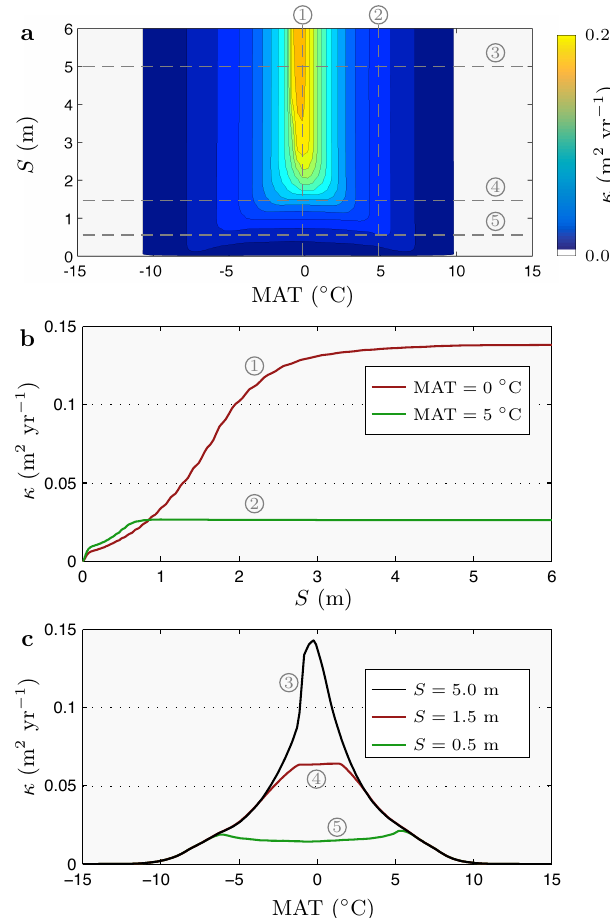
Figure 8. Panel (a) : contours of the integrated frost-creep effi- ciency, κ , as a function of MAT and sediment thickness, S . Loca- tions of transects plotted in ( b ) and ( c ) are shown with grey, dashed lines and